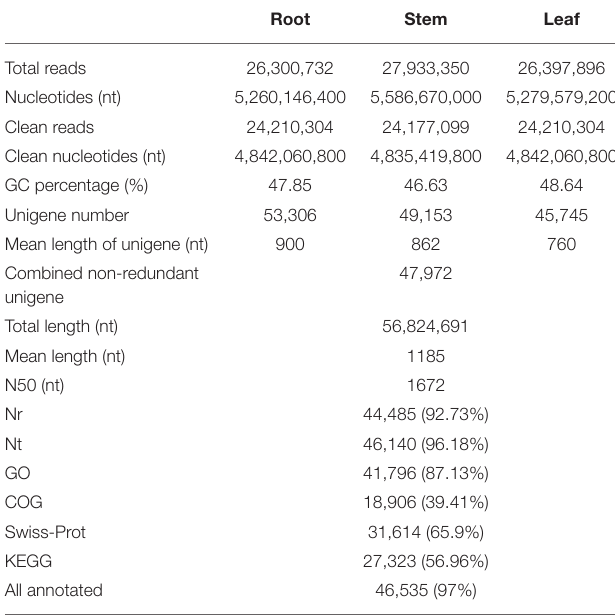
TABLE 1 | Summary of the assembly and annotation of the Sinapis alba